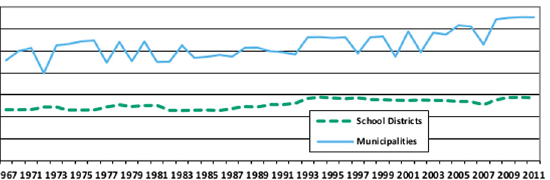
Fig 8. Number of Tax Revenue Sources by Government Type. This figure shows how the diversity of tax revenue sources increases over time for both municipalities and school districts.